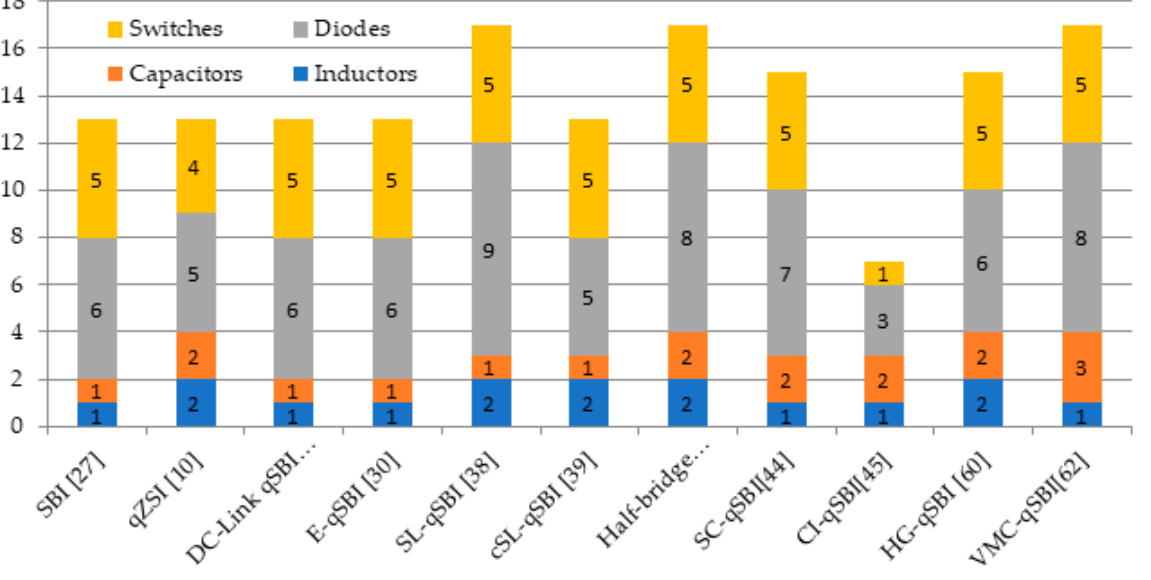
Figure 23. The components required for the topologies enlisted in Table 1.